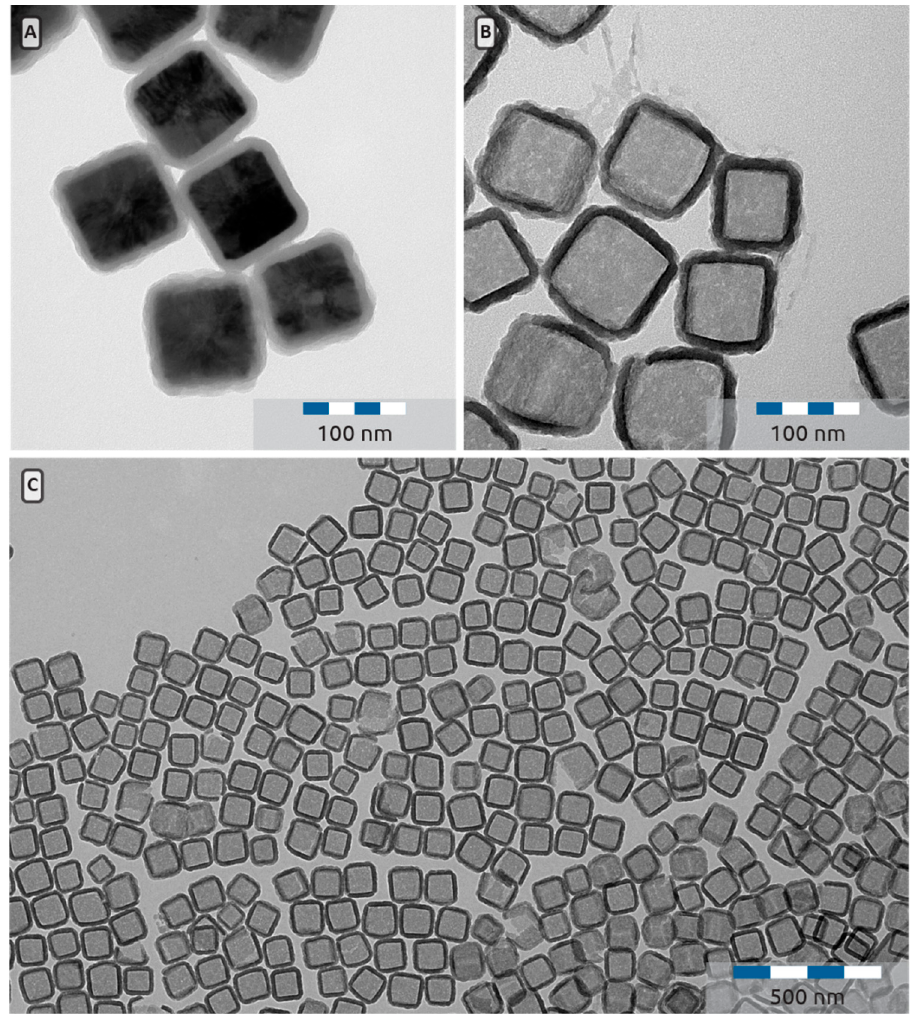
Figure 7. ( A ) TEM picture of Cu 2 O@SiO 2 core shell particles with an edge length of 112 ± 10 nm with a 13 nm shell. ( B ) TEM picture of hollow SiO 2 nanocubes obtained after treating the particles depicted in A with concentrated nitric acid. ( C ) Low magnification TEM image of an assembly of hollow silica nanocubes.